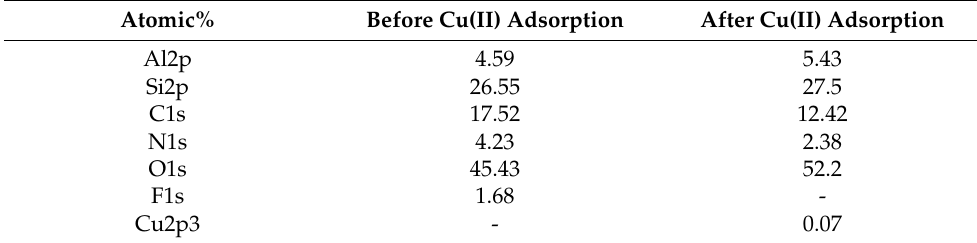
Table 8. Atomic ratio of the modified zeolite by XPS